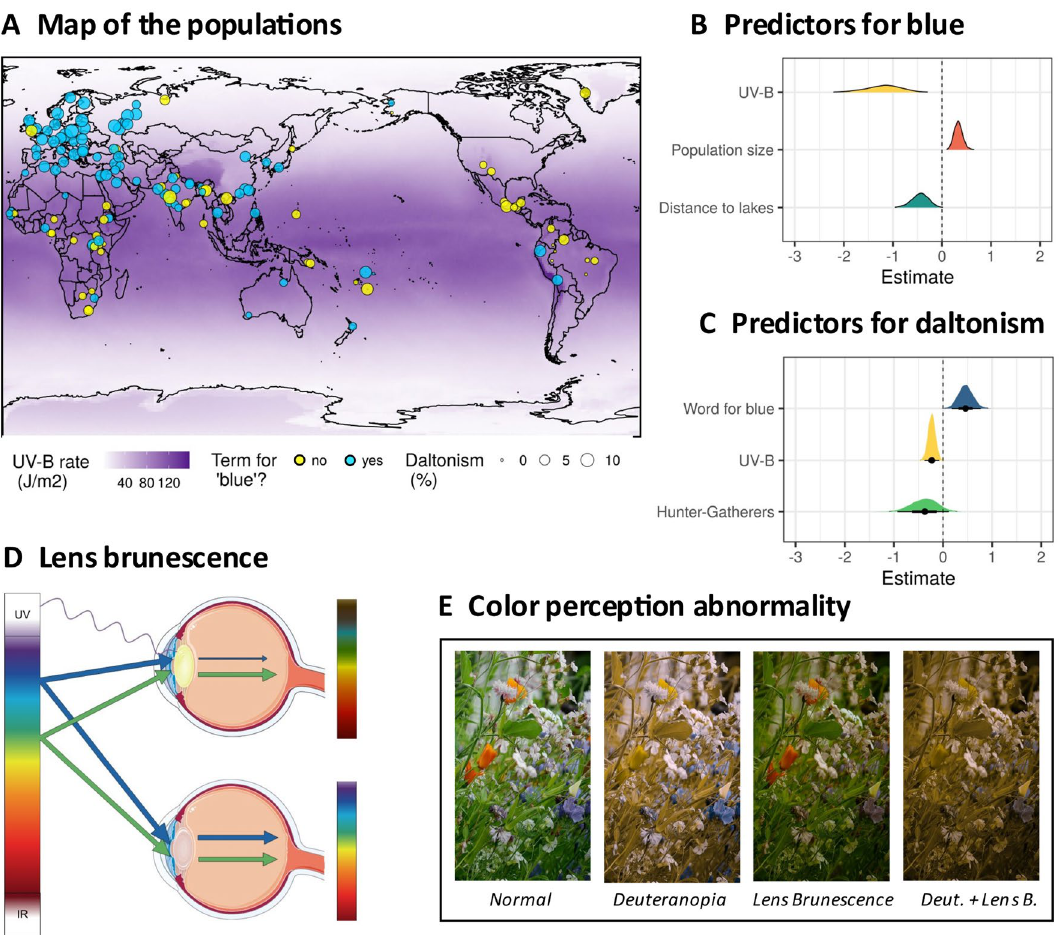
Figure 1. (Panel A ): Map of languages and populations in our data. Each circle represents one language and corresponding population, with the presence (blue) or absence (yellow) for a specific term for ’blue’. The circle radius is proportional to the population frequency of red/green abnormal color perception. The intensity of the background magenta is proportional to the incidence of UV-B radiation as given by the NASA Total Ozone Mapping Spectrometer (TOMS) for the year 1998. This map was generated with the package maps in 59 , which uses public domain data from the Natural Earth project https:// www. natur alear R version 4.0.5 thdata. com. (Panel B ): Posterior density plots of the best predictors of the presence of a word for blue across Bayesian regression models. (Panel C ): Posterior density plots of the best predictors of the frequency of red- green abnormal color perception across Bayesian regression models. The plots in panels ( B ) and ( C ) are based on the analyses detailed in the “Results” section and were generated using R 59 . (Panel D ): The lens brunescence hypothesis, as detailed in this paper. UV rays cause the lens to opacify and become yellower (top), filtering blue light, so that the perceived spectrum (on the right) contains less blue and more green, compared to the non- affected eye (bottom). (Panel E ): A simulation of different types of color perception abnormalities. From left to right: normal vision; one type of red-green abnormal color perception (deuteranopia); strong lens brunescence (yellow filter and darkening of the image); both lens brunescence and deuteranopia, hypothesized to result in decreased biological fitness relative to other color vision types. Background image cropped from a photo by Joydeep Pal on Unspalsh (https:// unspl ash. com/ photos/ i6kcc imZz_8) under a free-to-use license (https:// unspl ash. com/ licen se). For deuteranopia we used Coblis—The Color BLIndness Simulator (https:// www. color- blind ness. com/ coblis- color- blind ness- simul ator/) and checked the results with the Colorblind Web Page Filter (https:// www. toptal. com/ desig ners/ color filter). The lens brunescence filter is inspired by 30 : we used Adobe Lightroom classic version 10.0 with a yellow filter and darkening to simulate a Kodak yellow filter. For more details, see the “Results”, “Materials and Methods” and Supplementary adults across generations should generate negative pressure against the development of a ‘blue’ category or a tendency to lose it, while in populations with low exposure to UV-B incidence, other processes may proceed unhindered enabling the emergence and retention of ‘blue’. If true, we should observe a statistical tendency for fewer languages with a dedicated word for blue at high UV-B incidence (particularly close to the equator). Previous cross-cultural analyses linking UV-B incidence and the presence of ‘blue’ 16 may have been biased by the lack of control for various confounds (especially language contact and inheritance from a shared